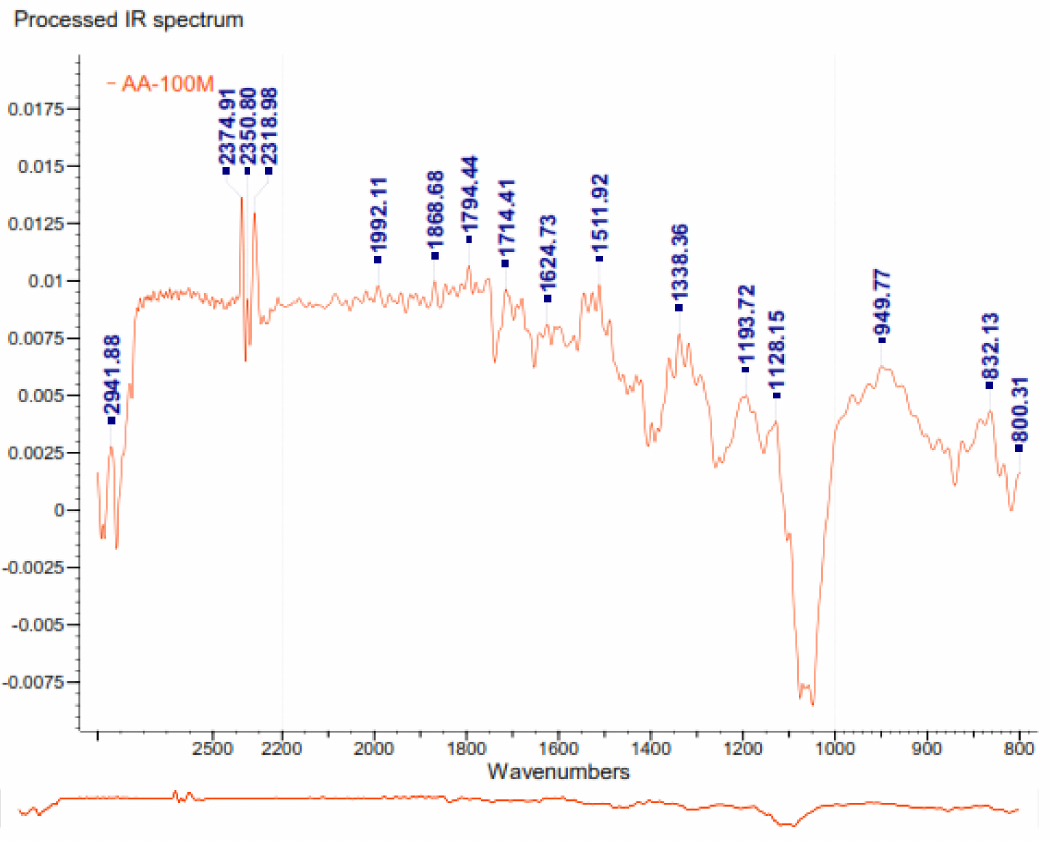
Figure A5. FTIR of sample AA-25T-75M. Table A5. Analysis of FTIR result for sample